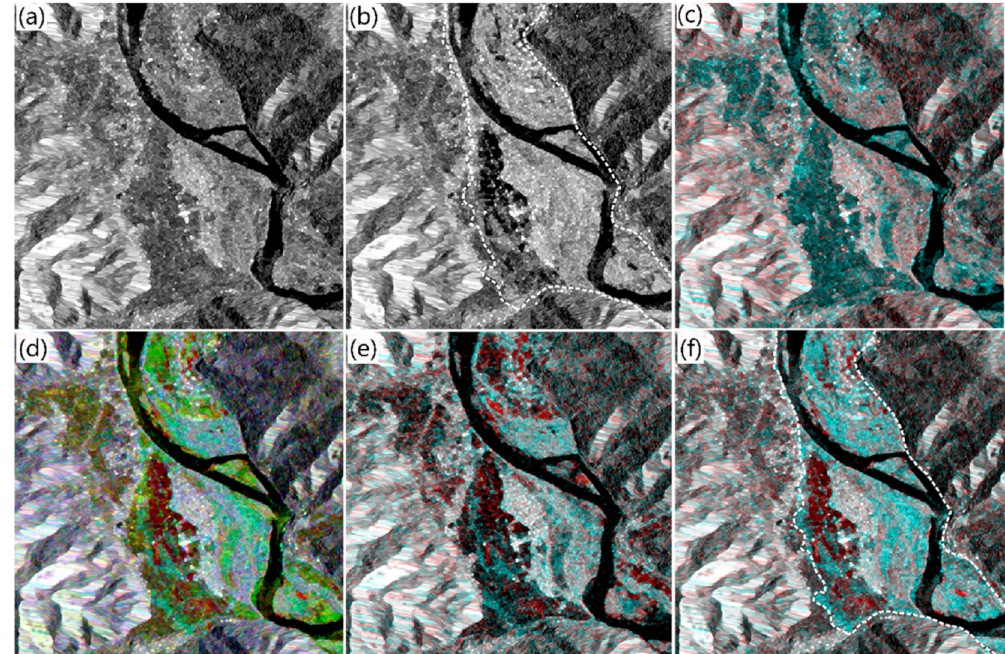
Figure 8. Sentinel-1 FCCs images with difference combination of SAR polarization. ( a ) VV SAR image on 2018.11.03; ( b ) VV SAR image on 2018.11.15; ( c ) R: 1103VV, G: 11.15VV, B: 11.15VH; ( d ) R: 1103VH, G: 11.15VV, B: 11.15VV; ( e ) R: 1103VV, G: 11.15VH, B: 11.15VV; ( f ) R: 1103VV, G: 11.15VV, B: 11.15VV. The white dotted line is the inundation range from Sentinel-2